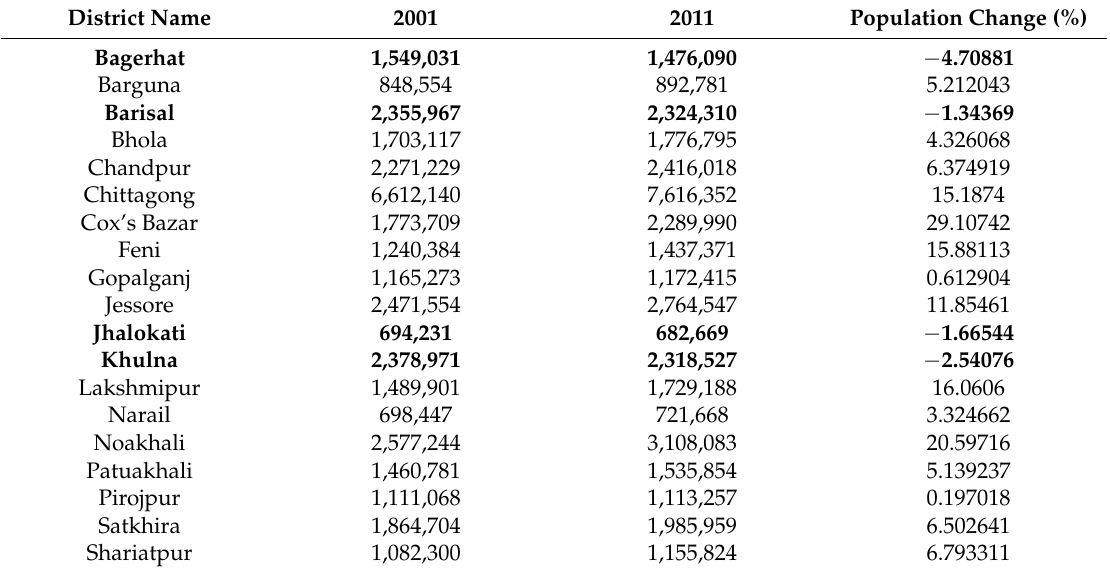
Table 9. Population change during 2001–2011 in the coastal areas of Bangladesh. Districts highlighted with bold face experienced a negative population